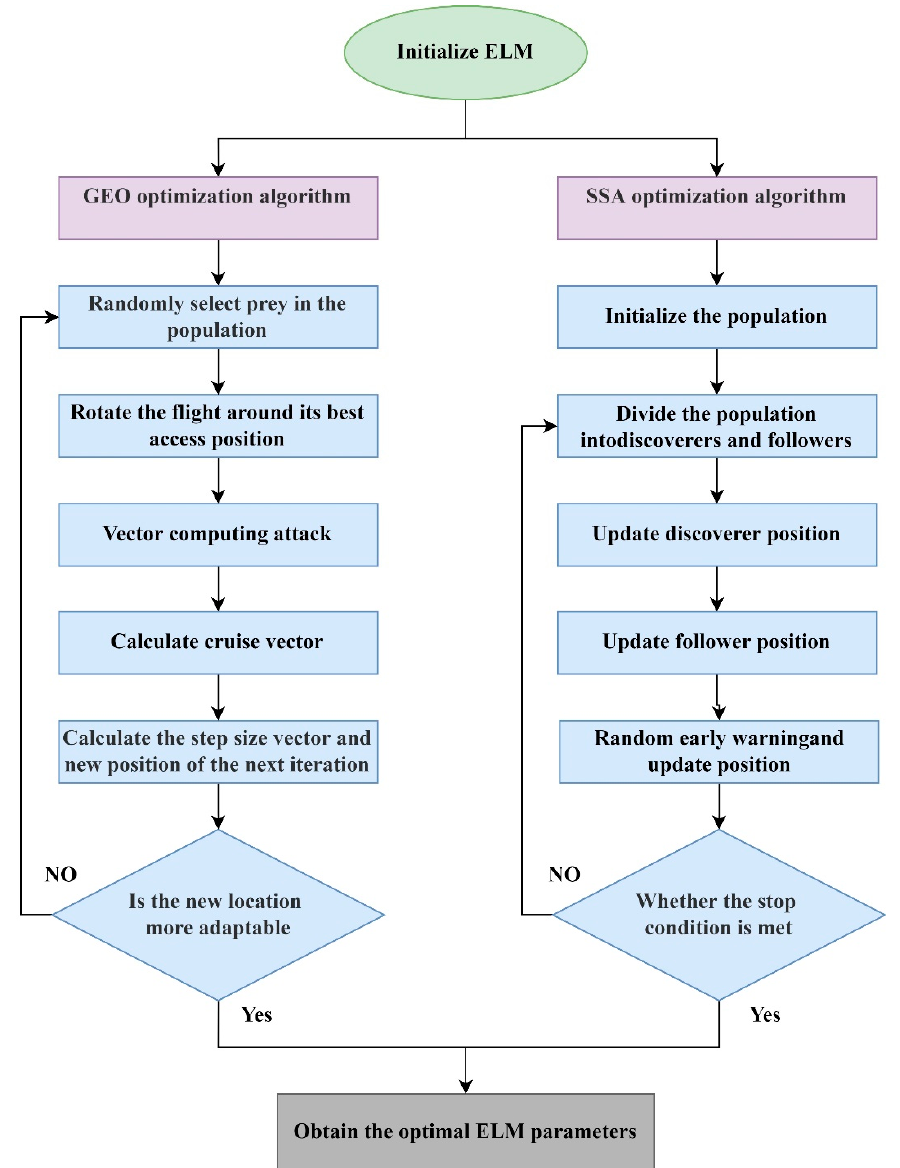
Figure 3. Process of heuristic algorithms to optimize ELM models.